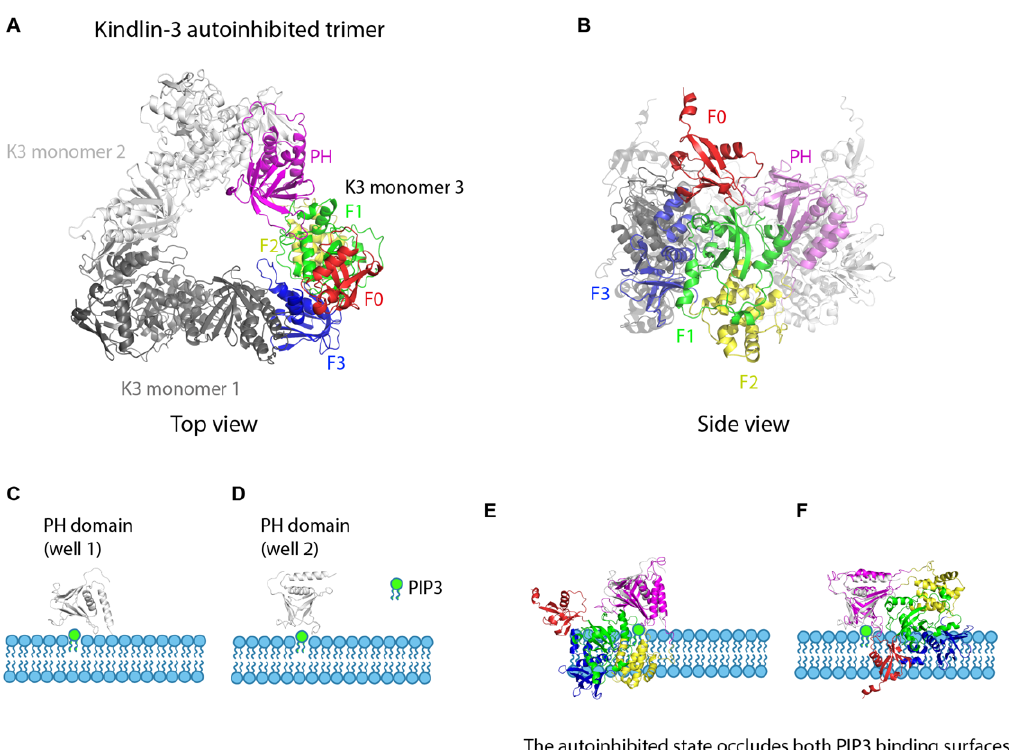
Figure 3. Kindlin autoinhibition and activation. ( A ). Crystal structure of the kindlin-3 autoinhibited homotrimer (top view). Kindlin-3 PH domain (magenta) interacts with the F3 subdomain of another kindlin-3 molecule (grey), thereby masking the integrin binding site of kindlin-3. F0, red, F1, green, F2, yellow, F3, dark blue. ( B ). Crystal structure of the kindlin-3 autoinhibited homotrimer (side view). ( C , D ). Two wells [well 1 ( C ) and well 2 ( D )] of the free kindlin-3 PH domain binding to PIP3 (green) in the plasma membrane. ( E , F ). The autoinhibited state occludes both PIP3 binding surfaces of the PH domain. Superimposition of the autoinhibited kindlin-3 monomer onto the kindlin-3 PH domain in ( C , D ) shows that at least 2 domains would clash with the membrane containing PIP3.